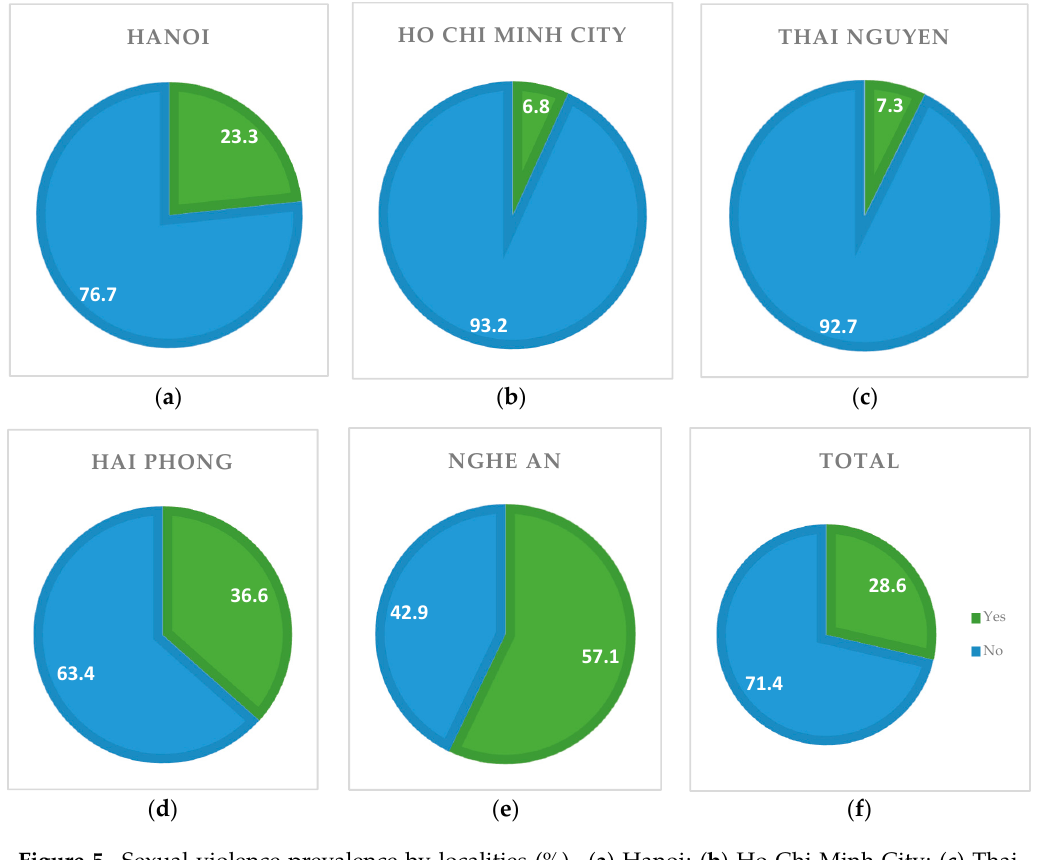
Figure 6. Sexual violence by age groups (%). In terms of violence perpetrators, clients were cited by 60% of the survivors of general physical violence. Intimate partners were also quite common, as 27.2% of the survivors mentioned their husband and 31.2% pointed to their boyfriend or primary sexual partner as the perpetrators. Other violence perpetrators include employers, pimps, co-workers, family members, and law enforcers such as police officers. In addition, 74.3% of the surveyed FSW reported to have suffered from violence caused by their clients. Some other perpetrators who were mentioned as inflicting violence on the FSWs included family members, brothel owners, sex brokers, and co-workers. Physical violence was perpetrated on 49.2% of the FSW respondents, while the prevalence of emotional and sexual violence was 72.9% and 55.1%, respectively. The three most common types of sexual violence committed by clients were coerced sex, rape threats, and sexual harassment. It is worth noting that in-depth interviews suggest that FSW working in organized brothels seem less likely to fall victim to violence from clients. These sex workers usually operate in certain places, such as designated hotels or guest houses, which are known to their managers and colleagues, who provide assistance and protection in case of emergency. Meanwhile, independent FSWs lack all support in sex work and face increased risks of all forms of violence. Box 3 presents the respondents’ experience of different types of sexual violence.